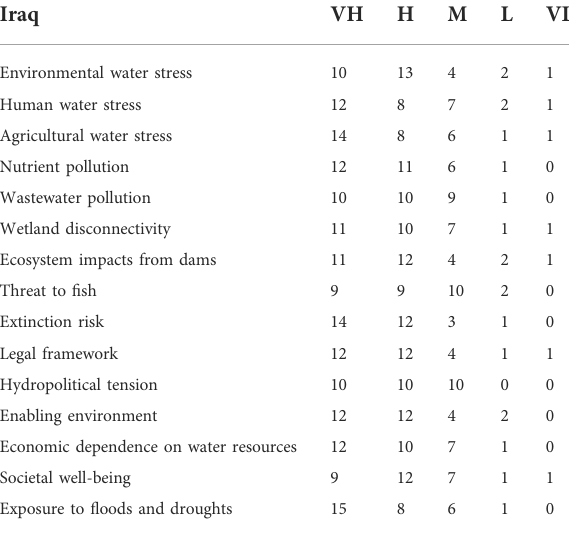
TABLE 6 Fuzzy comprehensive evaluation matrix for